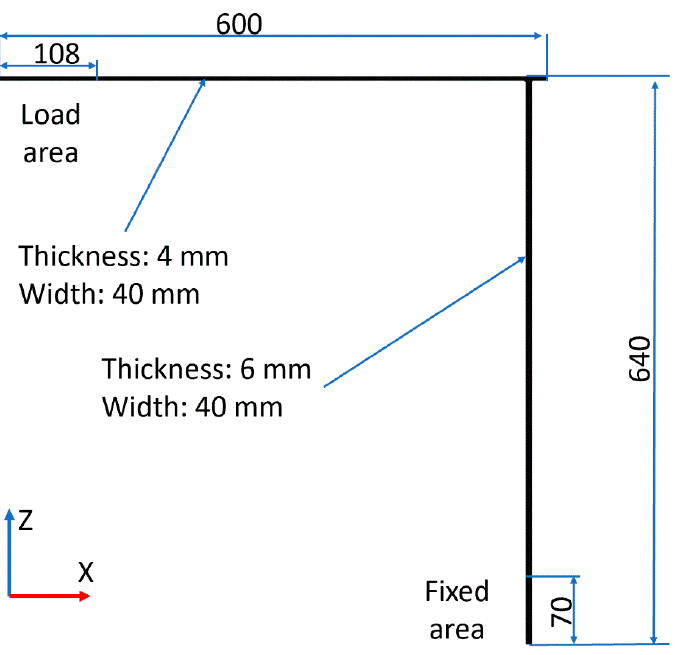
Figure 2. Scheme of the examined tower-crane-like structure. During the experiments, a specimen was fixed in a pneumatic clamp. Standard vision markers in the shape of black and white boxes were used. They were placed on the side surface of the sample. The vision markers are used to determine the deflection of the structure at a later stage in this work using image processing algorithms. Their shape and placement were the same as in the numerical model discussed in more detail in Section